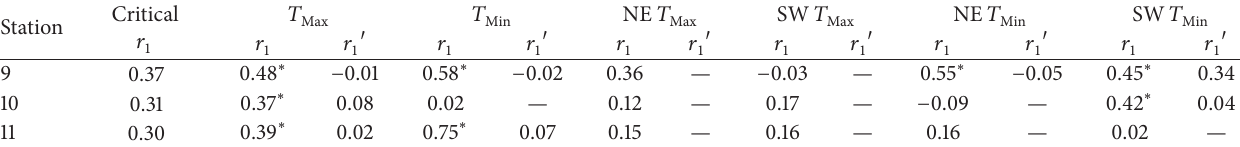
Table 3: Lag-1 serial correlation values for temperature variables before and after prewhitening.